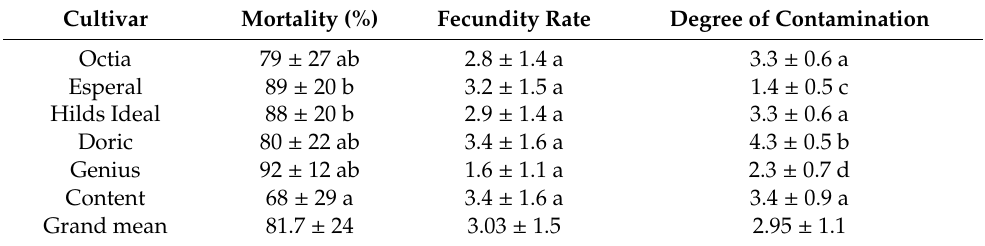
Table 2. Cabbage whitefly antibiosis results (o ff spring mortality, fecundity (number of eggs per day and female) and estimated degree of contamination caused by CWF infestation of the field trial (means ± SD). Within a column, means with di ff erent letters are significantly di ff erent (GLMM / LMM, p ≤